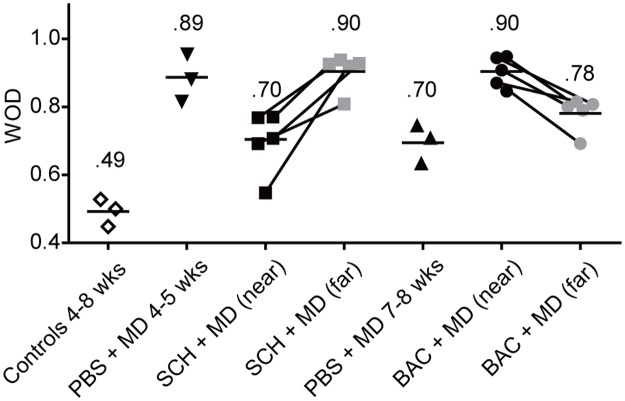
WOD scores for each kitten in each treatment group.Discrete symbols represent WOD scores obtained for individual animals, while the labeled bar indicates the group mean. Note that WOD scores were significantly lower near verses far from the SCH50911 infusion site (p = 0.0098, paired t-test). In contrast, WOD scores near the baclofen infusion site were significantly higher than those far from the baclofen infusion site (p = 0.003, paired t-test). Conventions as in Fig 1.